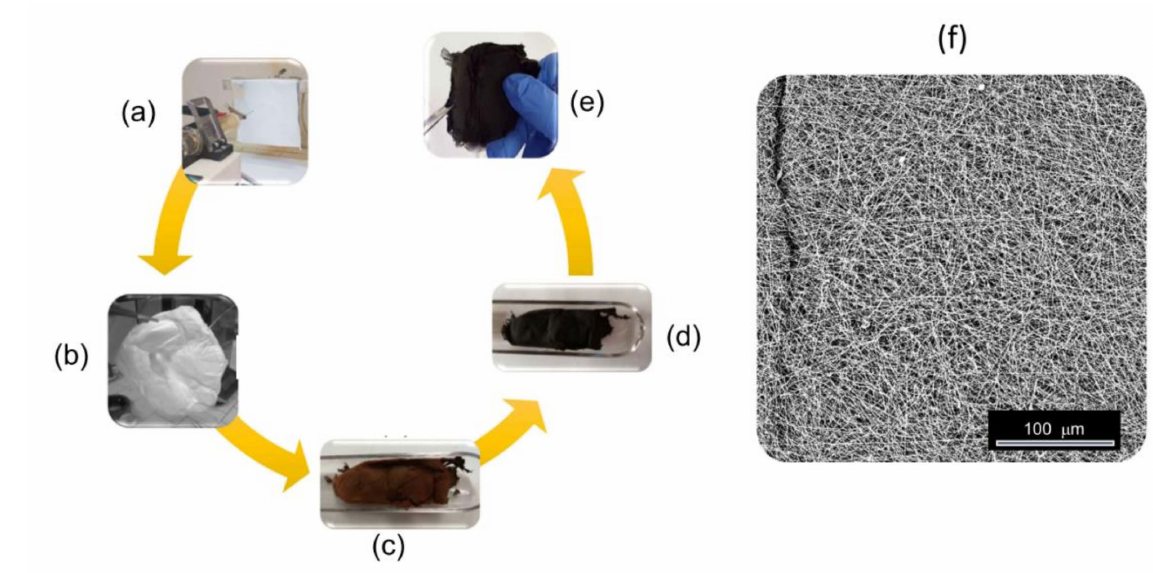
Figure 1. Process for the production of the sorbent membranes: ( a ) as-spun membrane after ( b ) peeling from the collector, ( c ) stabilisation and ( d ) carbonisation, ( e ) as-obtained self-supporting paper-like membrane and ( f ) its fibrous microstructure as evidenced by